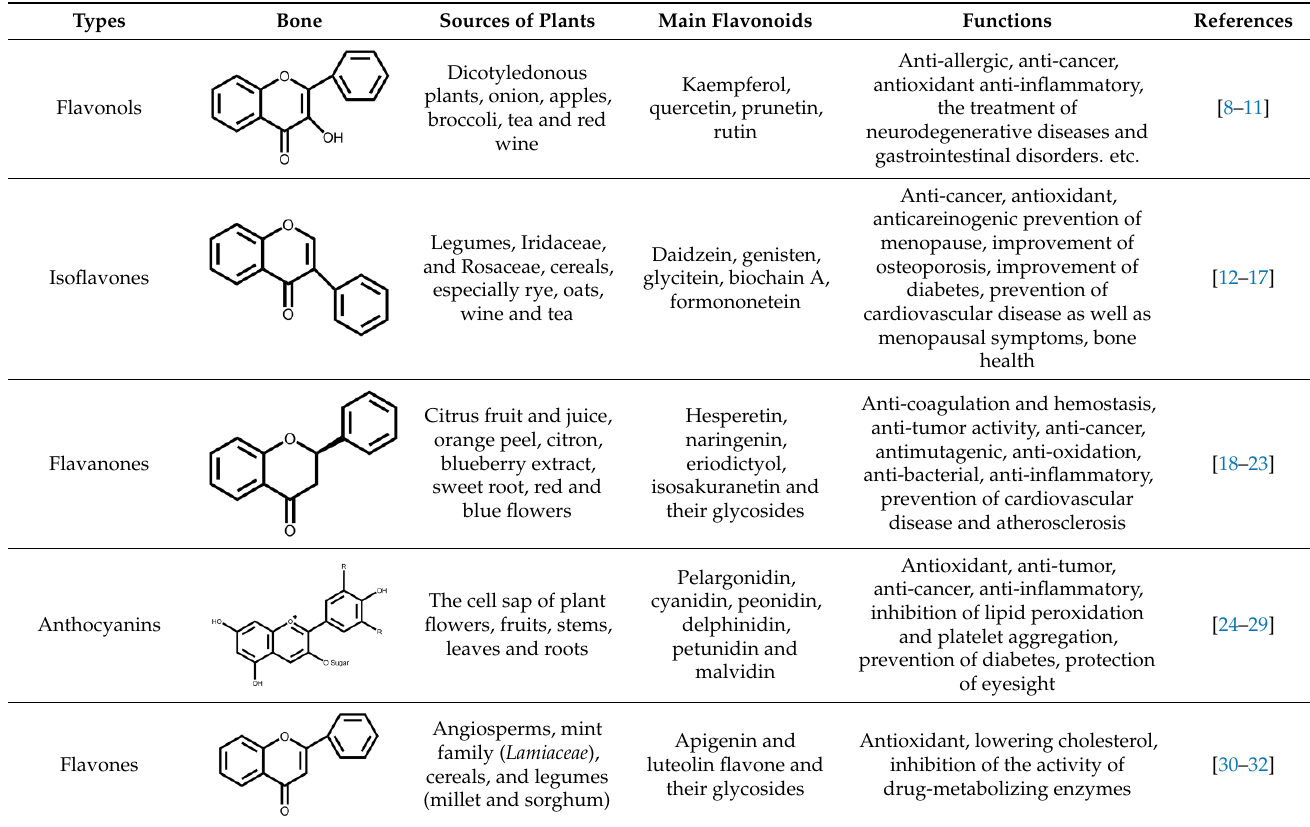
Table 1. Classification of flavonoids.